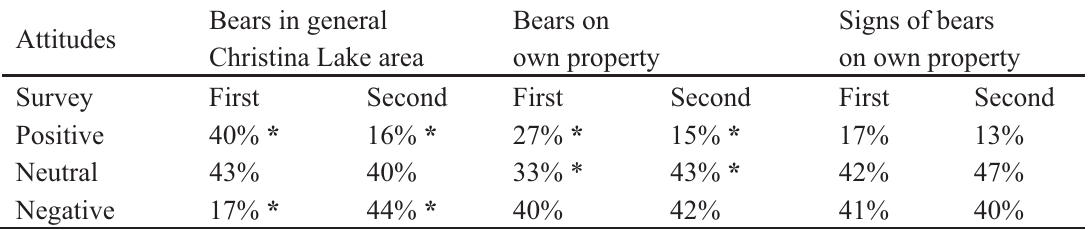
Table 1. Percentage of respondents stating that they felt positive, neutral or negative towards general bear sightings across two surveys (February and December 2011) a